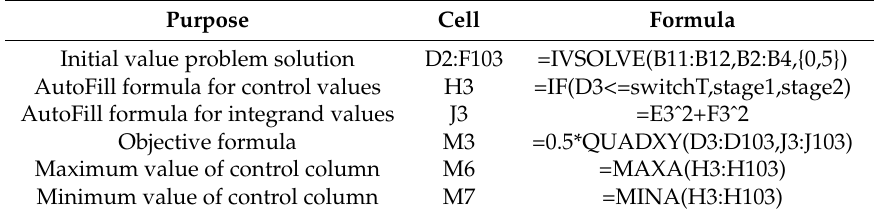
Table 1. Formula definitions used for solving optimal control problem